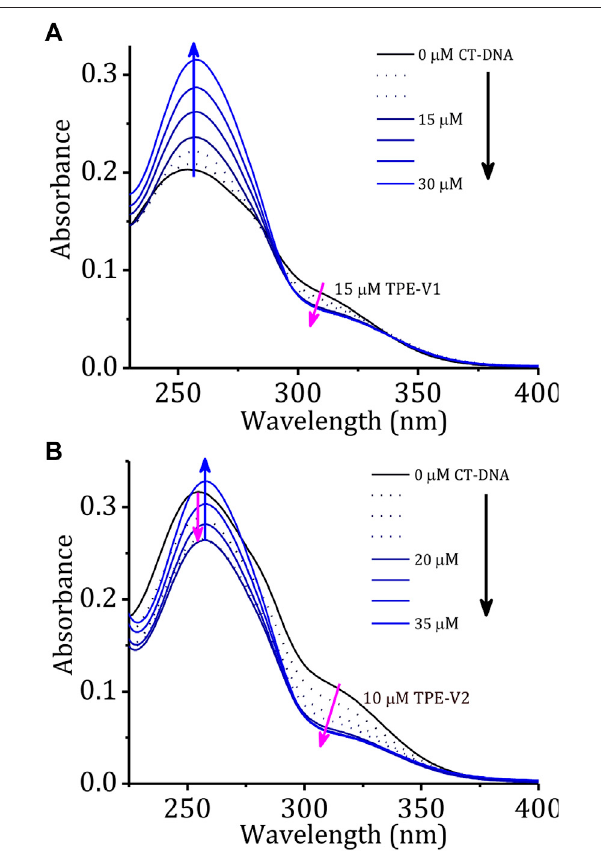
FIGURE 1 | Changes in the absorption spectra of (A) TPE-V1 (15 μ M) and (B) TPE-V2 (10 μ M) in Tris buffer with the sequential addition of CT-DNA (every single addition makes 5 μ M in the fi nal